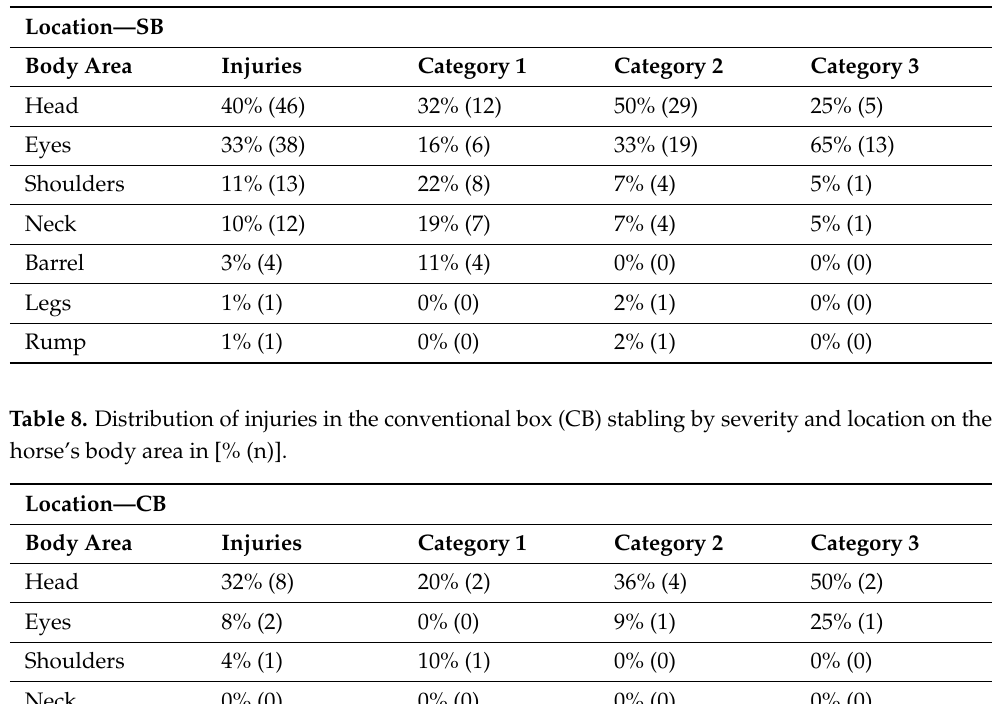
Table 7. Distribution of injuries in social box (SB) stabling by severity and location on the horse’s body area in [% (n)].